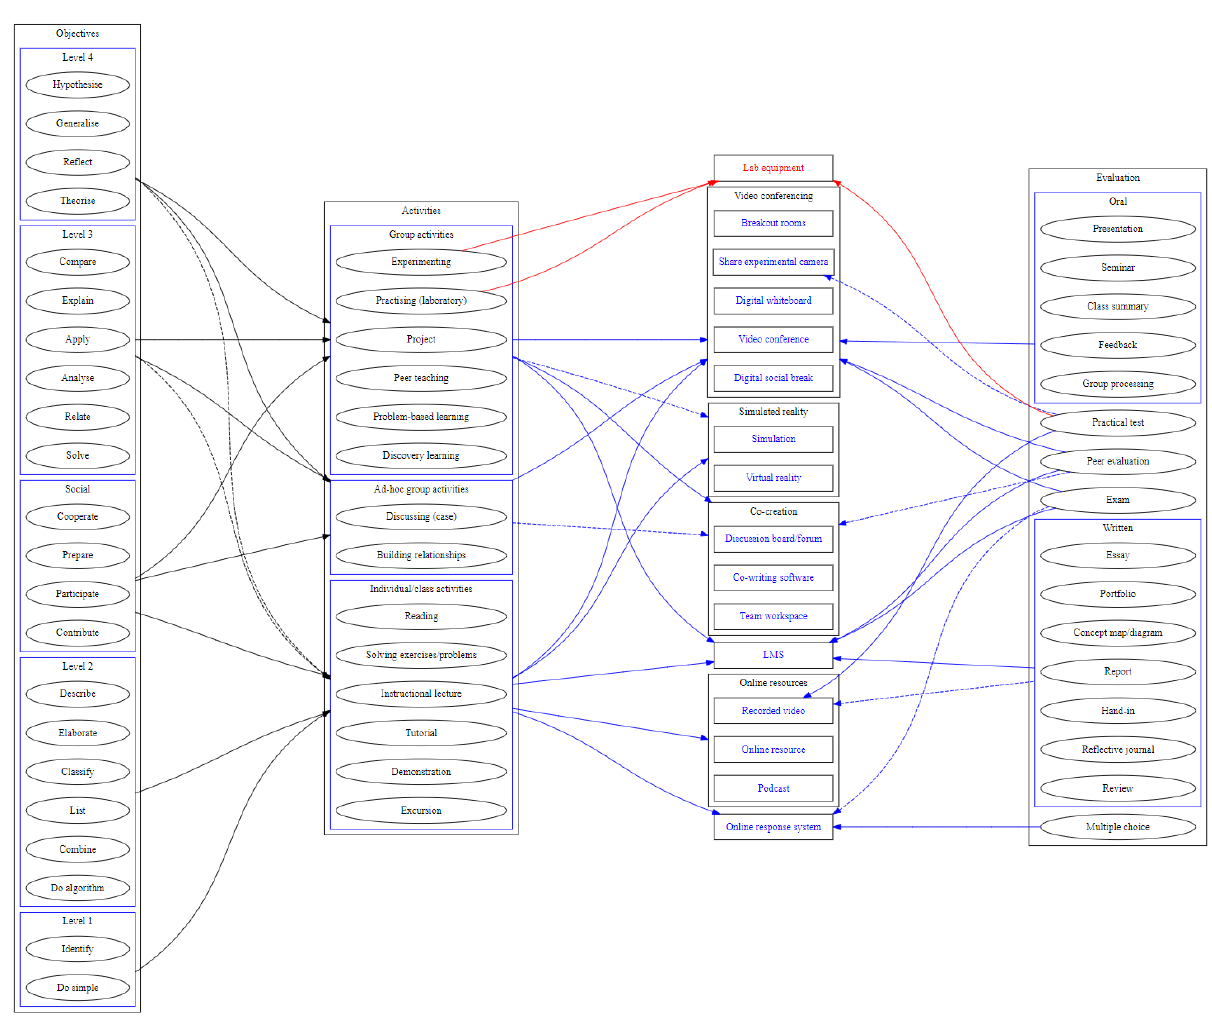
Figure 4: Graph of online learning objectives, learning activities, evaluation methods, and digital and physical resources. Arrows from activities to physical resources are shown in red, and to digital resources in blue. Solid lines indicate a strong link between concepts, dashed ( − − ) lines indicate a weaker link between concepts. Connections made to/from a cluster of concepts indicate that all concepts in the cluster are linked through the